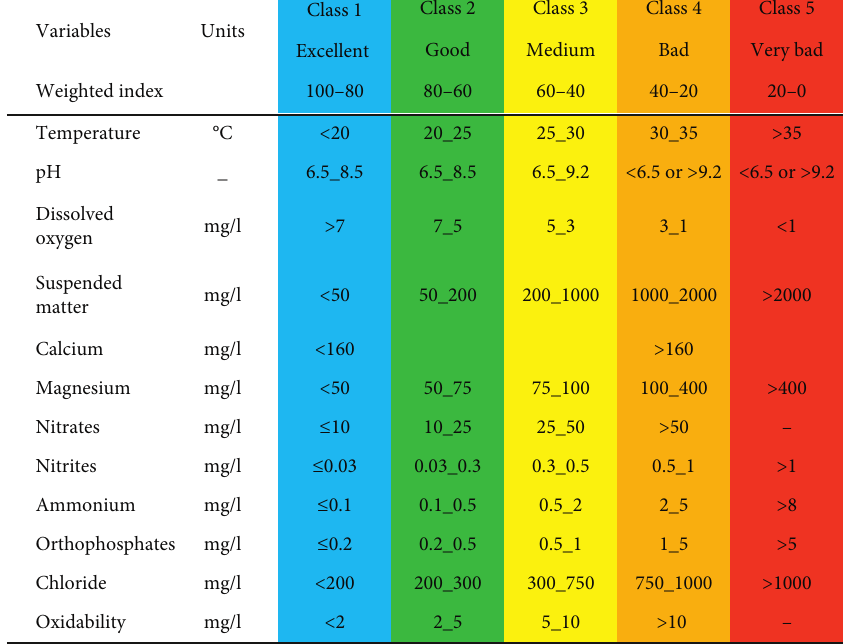
Table 2: Extract from the general grid of physicochemical quality used for the classification of surface water [18].